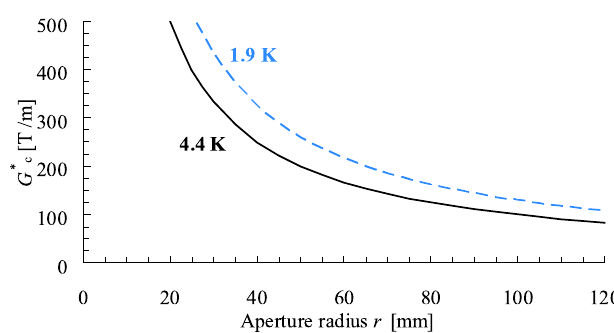
FIG. 4. (Color) Theoretical upper bound G (cid:4) for Nb-Ti as a function of the aperture radius.